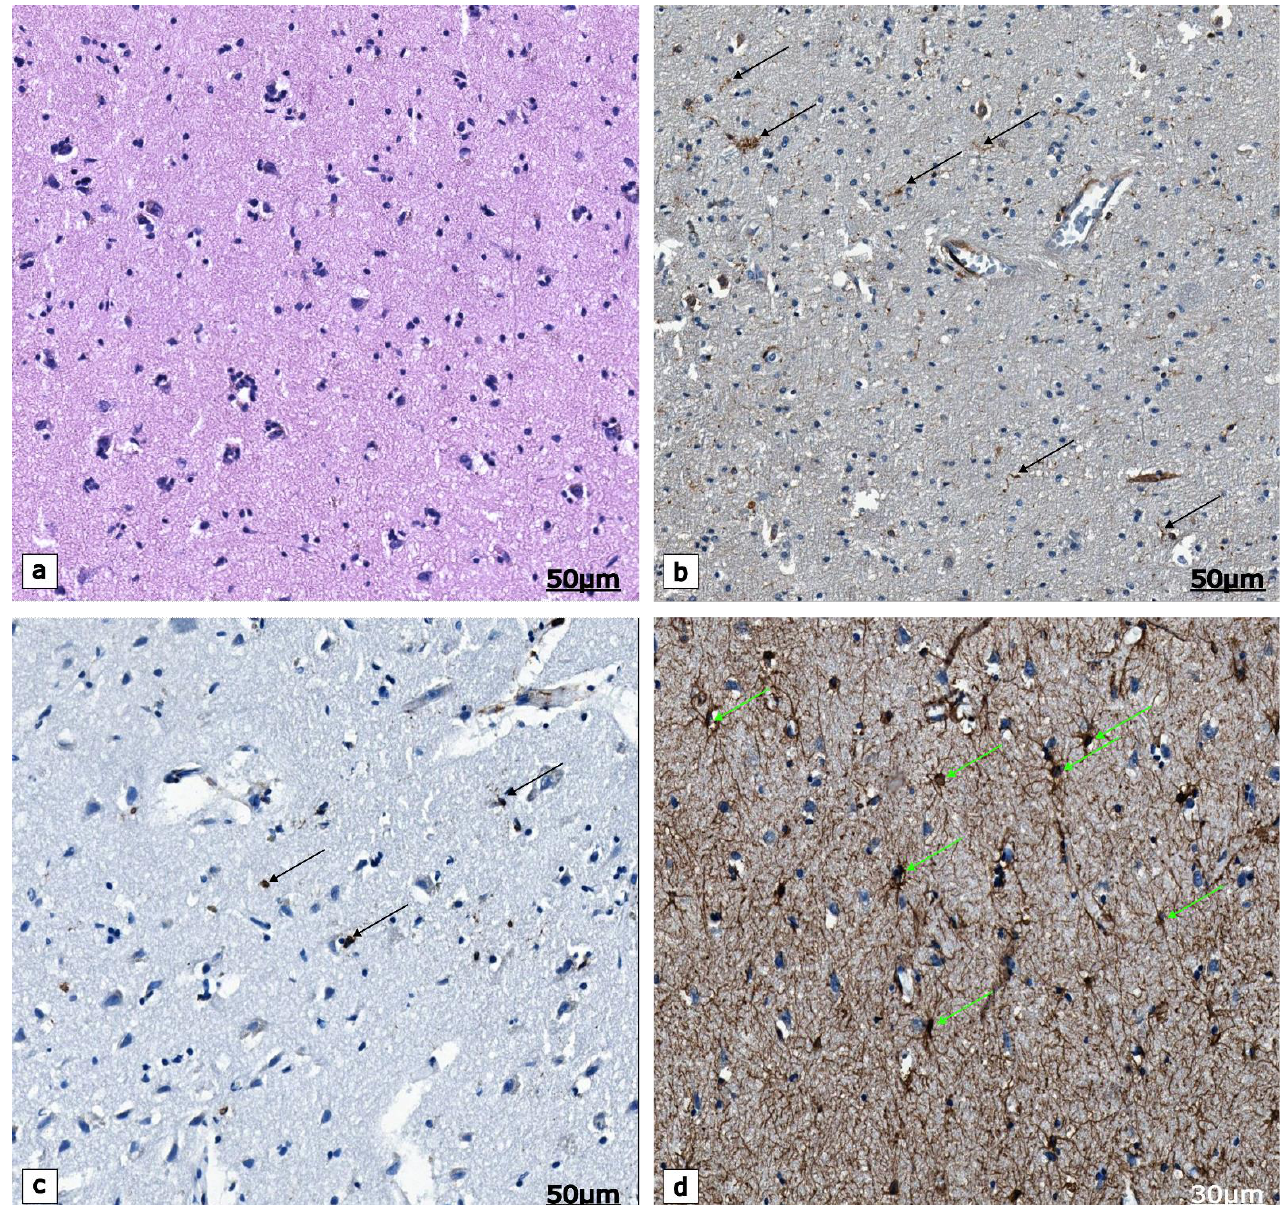
Figure 6. The structural appearance of the inferior parietal lobule of OA patient, post-mortem bran tissue. ( a ) An overview of the lobe as observed by the use of routine staining; ( b ) The interface of the gray and white matter presents with brown coloration in the cell bodies and moss-like processes of microglial cells (arrows), Iba1 immunohistochemistry; ( c ) Microglial cells (arrows) visualized by the presence of brown reaction products confirmed by the use of an anti-CD68 antibody, CD68 immunohistochemistry; ( d ) Astrocytes (arrows) that demonstrate strong expression of the glial fibrillary acidic protein (GFAP), GFAP immunohistochemistry. Scale bars: ( a – c ) 50 μm; ( d ) 30 μm.